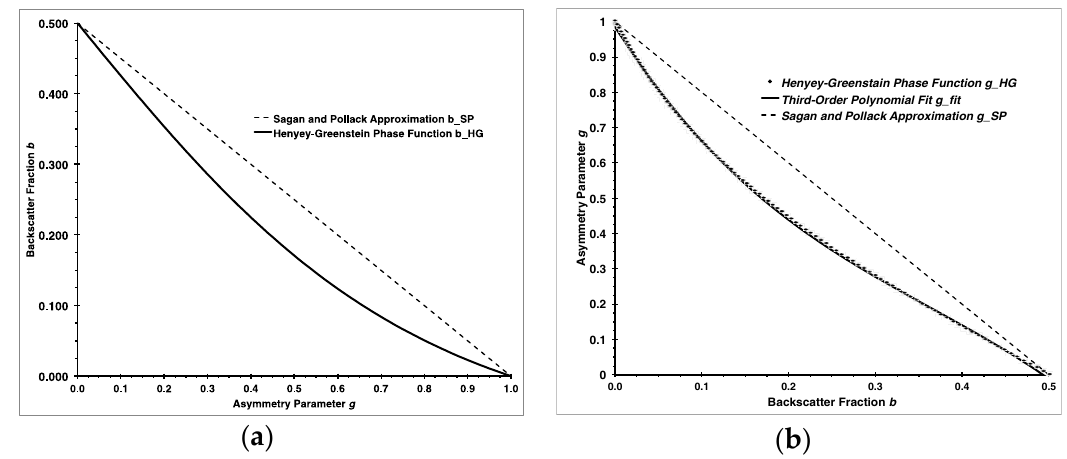
Figure 3. ( a ) The Henyey-Greenstein (HG) backscatter fraction b HG as function of asymmetry parameter g shown as solid line together with a linear approximation by Sagan and Pollack [28] shown as dashed line; ( b ) The asymmetry parameter g (solid dots) and a third-order polynomial approximation g_fit (solid line) as function of Henyey-Greenstein backscatter fraction b HG together with a linear approximation by Sagan and Pollack [28] shown as dashed line.